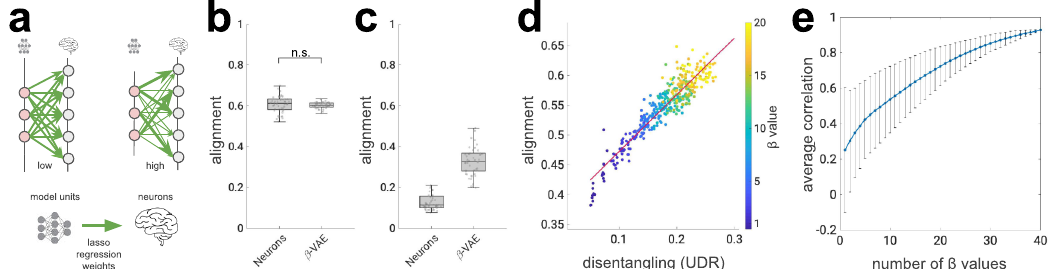
Fig. 3 Strong alignment between single neurons and disentangled units. a Schematic of alignment score 29, 63 . Green arrows, lasso regression weights obtained from predicting neural responses from model units (thickness indicates weight magnitude). High alignment scores are obtained when per-neuron regression weights have low entropy (one strong weight); high entropy (all incoming weights are of equal magnitude) results in low alignment scores. b β - VAE alignment scores match the ceiling provided by subsets of neurons ( p = 0.4345, two-sided Welsch ’ s t -test). Circles, alignment per model ( n = 51) or neuron subsets ( n = 50). Boxplot centre is median, box extends to 25th and 75th percentiles, whiskers extend to the most extreme data that are not considered outliers, outliers are plotted individually. Source data are provided as a Source Data fi le. c Alignment scores per model ( n = 51) or neuron subsets ( n = 50) against arti fi cial neural responses (linear recombination of original neural responses). Boxplot centre is median, box extends to 25th and 75th percentiles, whiskers extend to the most extreme data that are not considered outliers, outliers are plotted individually. Source data are provided as a Source Data fi le. d Alignment scores correlate with the disentanglement quality of latent units obtained from 400 β -VAE models trained with different β values (indicated by colour). UDR, Unsupervised Disentanglement Ranking 31 , measures the quality of disentanglement, higher is better. Red line, least squares fi t ( r = 0.96, Pearson correlation). Source data are provided as a Source Data fi le. e Running correlation between UDR and alignment scores across subsets of models. Models in each subset were trained with different β values, with the number of β values in each subset indicated on the x -axis. Rightmost circle, Pearson correlation across 400 β -VAE models, spanning 40 β values as reported in ( d ). Leftmost circle, average across 40 Pearson correlations, each calculated with 10 models with a single β value. Bars, standard deviation. Source data are provided as a Source Data fi